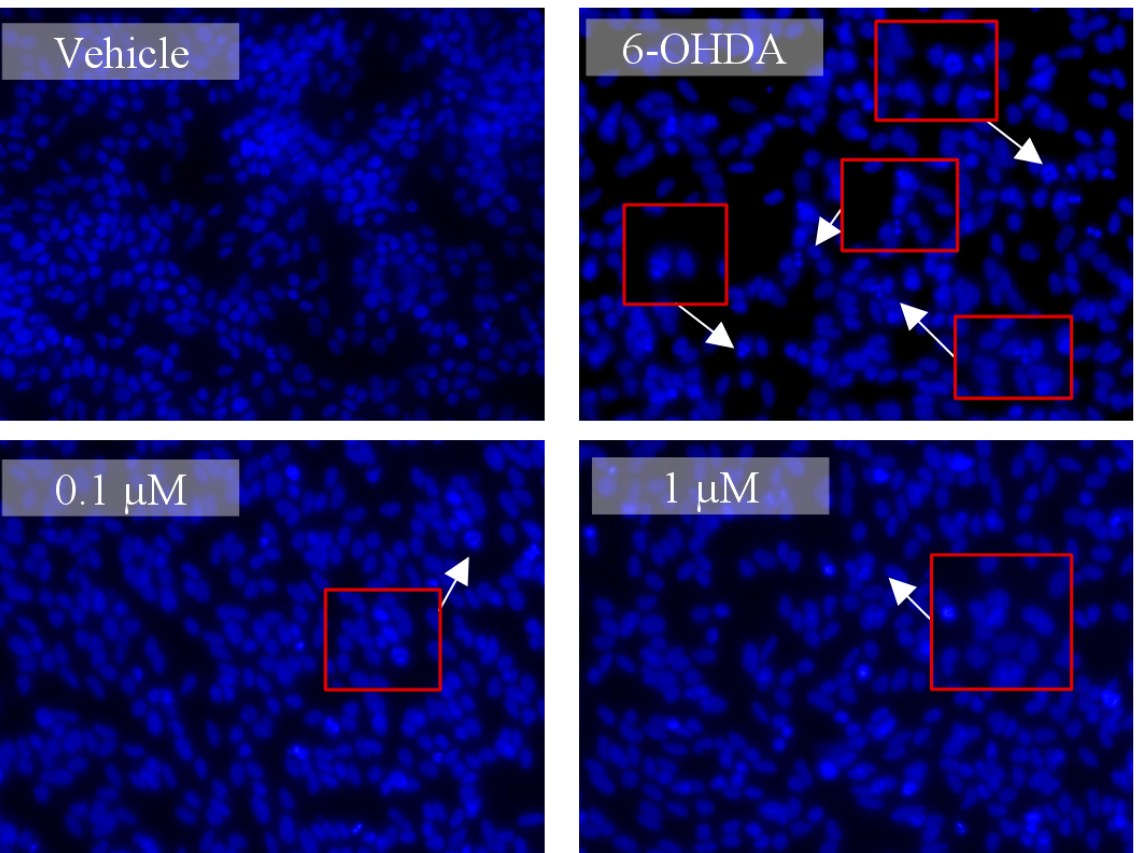
Figure 4. Nuclear morphology of SH-SY5Y cells stained with DAPI probe. SH-SY5Y cell stained with DAPI showing the anti-apoptotic effect of the Lut7 (0.1 or 1 µ M) against neurotoxicity mediated by 6-OHDA (100 µ M; 24 h). Arrows show nuclear abnormalities (fragmentation pattern), which is an indicator of apoptosis. Red Boxes represent the amplified zone where is visible nuclear changes.